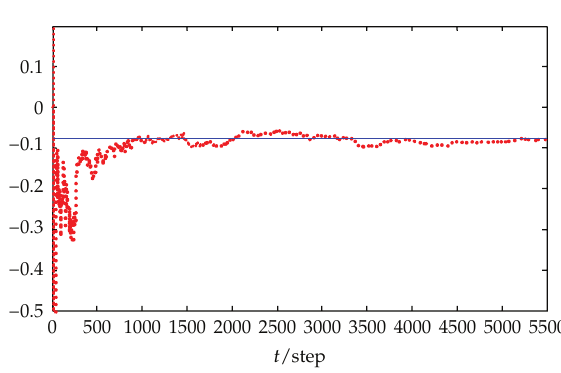
(cid:11) d (cid:5) t (cid:6) . 21